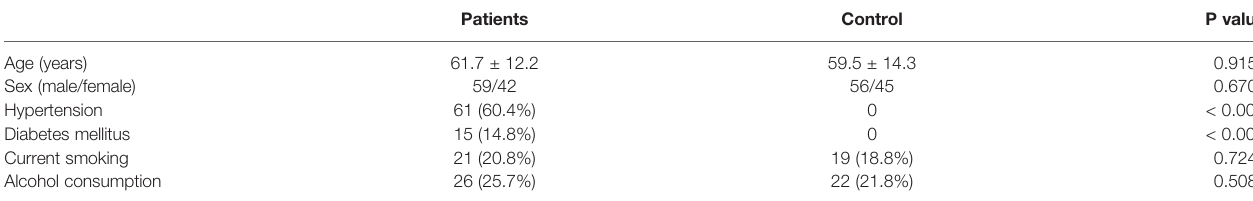
TABLE 1 | Comparisons of demographic data and vascular risk factors between controls and patients with acute intracerebral hemorrhage. Patients P value